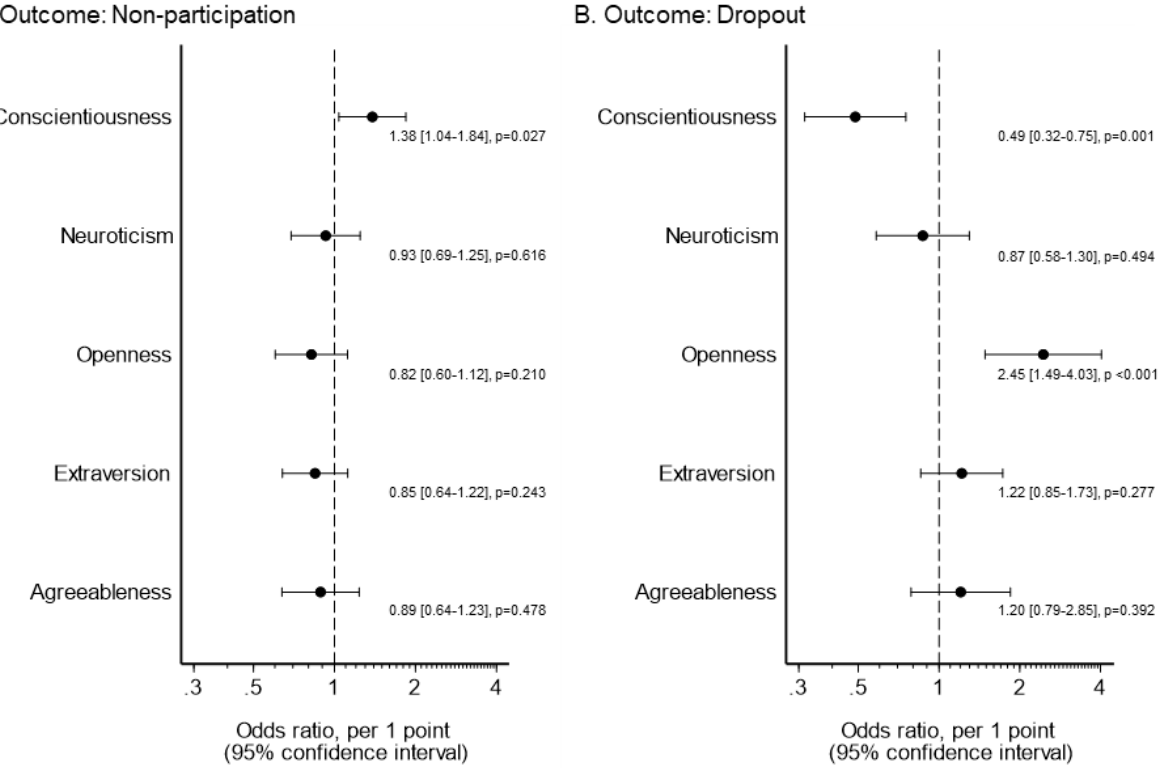
Figure 3. Results of logistic regression analysis ( n = 163). ( A ) Dependent variable: non-participation in outpatient cardiac rehabilitation. ( B ) Dependent variable: dropout from outpatient cardiac rehabilitation. Adjusted for age and gender.